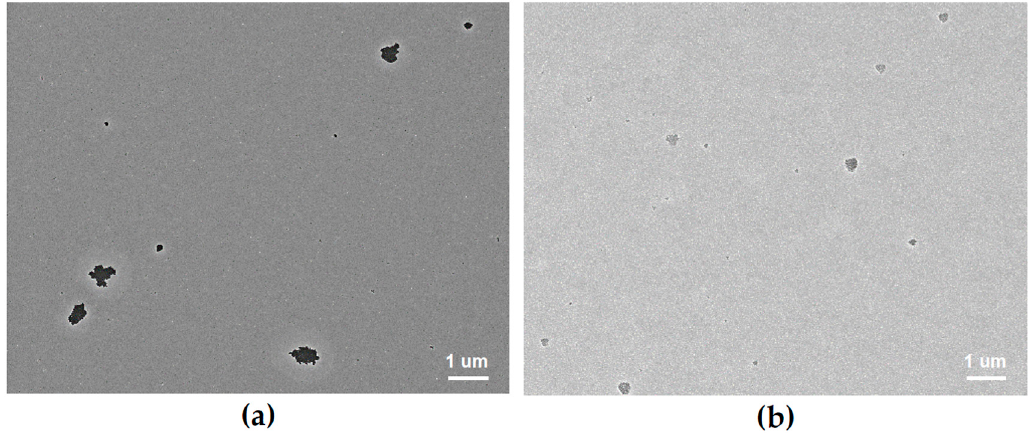
Figure 3. Over-time SEM surface images of Ag films after 19 months (7000 × magnification): ( a ) 25 nm, ( b ) 70 nm.